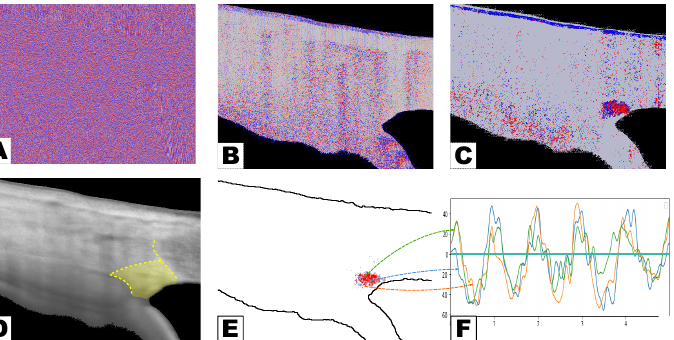
Figure 4. Flowchart of signal processing. ( A ), OCT phase signal in the iridocorneal cross section. ( B ), PhDiff signal after phase images registration and phase compensation. ( C ), PhDiff signal pro- cessed by the Butterworth filter. ( D ), set region of interest. ( E ), candidate trabecular meshwork motion signal. ( F ), trabecular meshwork motion waveform. The color map in ( A – C ) was generated from the “Lookup tables” function of ImageJ software (NIH, USA). The red/blue represent the reverse diffuse directions of the